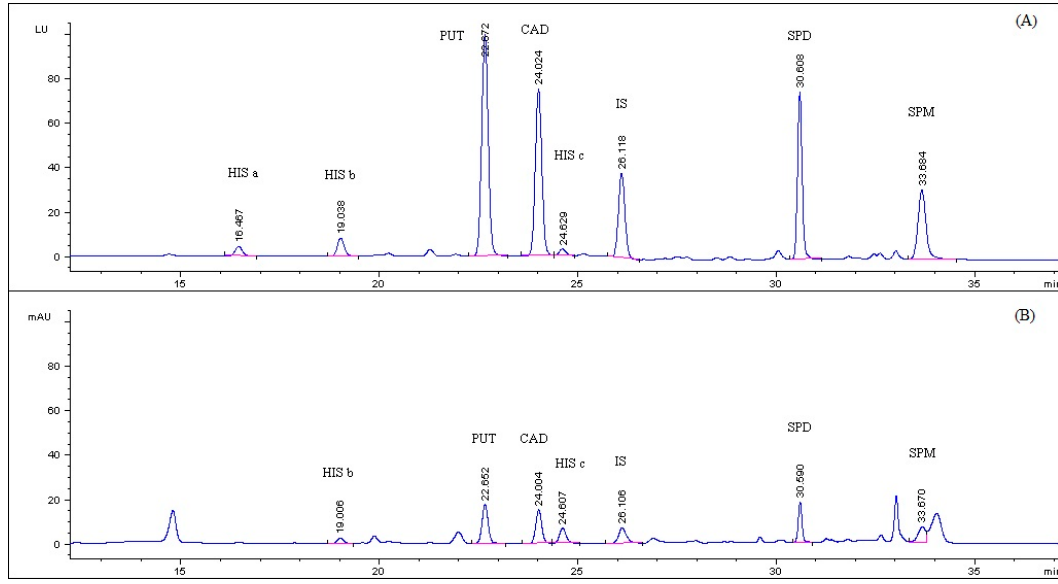
Figure 3. ( A ) HPLC-FLD; ( B ) HPLC-UV chromatogram of PSCl derivatized BAs standard solution of 0.5 µ g mL − 1 and 1,7 diaminoheptane at 0.3 µ g mL − 1 . (HIS a, HIS b, HIS c: Histamine, PUT: Putrescine,